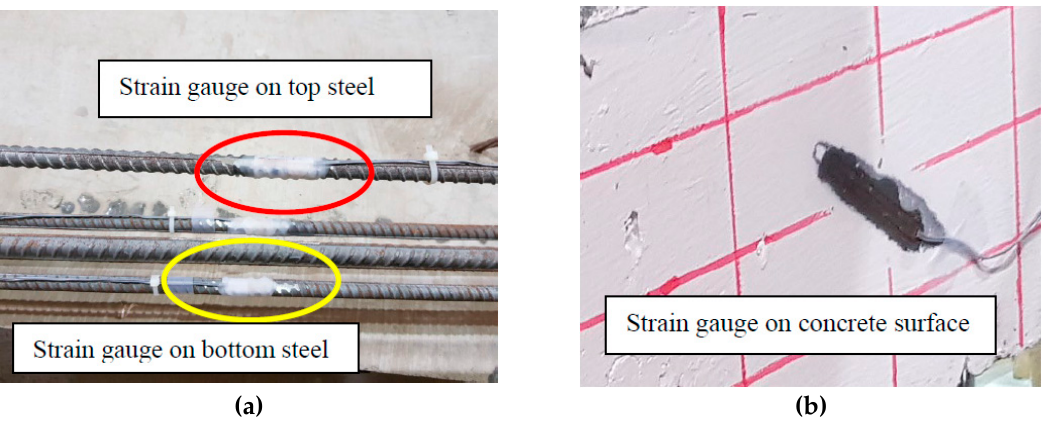
Figure 6. Strain gauges on steel bars and concrete surface. ( a ) Strain gauges on top and bottom steel bars, ( b ) Strain gauges on concrete surface.